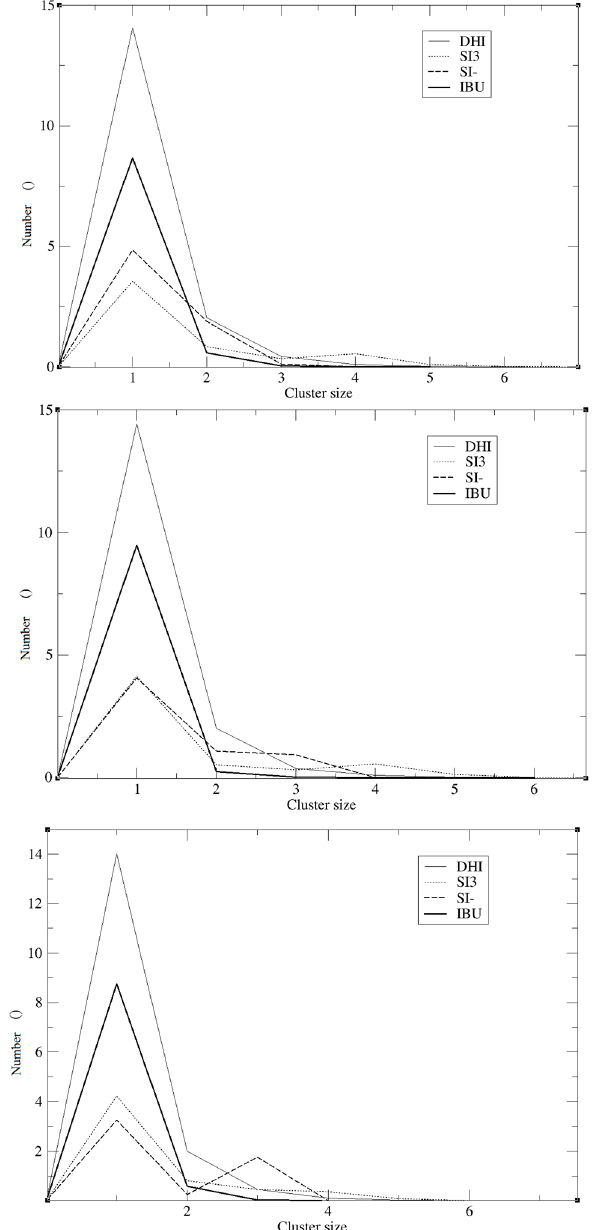
Figure 4. Cluster analysis of the three MD replicas.